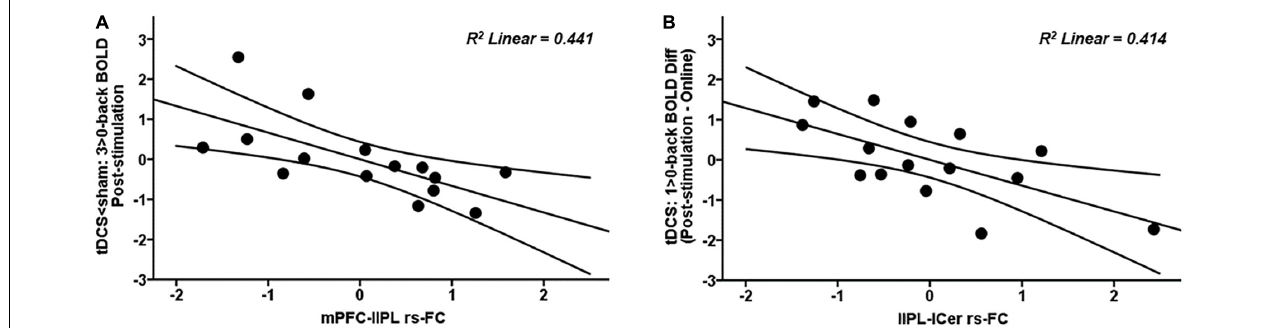
FIGURE 8 | Scatter plots showing the relationships in the tDCS group between (A) mPFC-lIPL rs-FC and post-stimulation 3 > 0-back BOLD signal (in the tDCS < sham fMRI cluster) and (B) lIPL-lCer rs-FC and 1 > 0-back difference in BOLD signal (in the post-stimulation – online fMRI cluster). Data are presented with z scores. tDCS, transcranial direct current stimulation; BOLD, blood oxygen level dependent; Diff, difference; mPFC, medial prefrontal cortex; lIPL, left inferior parietal lobule; rs-FC, resting-state functional connectivity; lCer, left